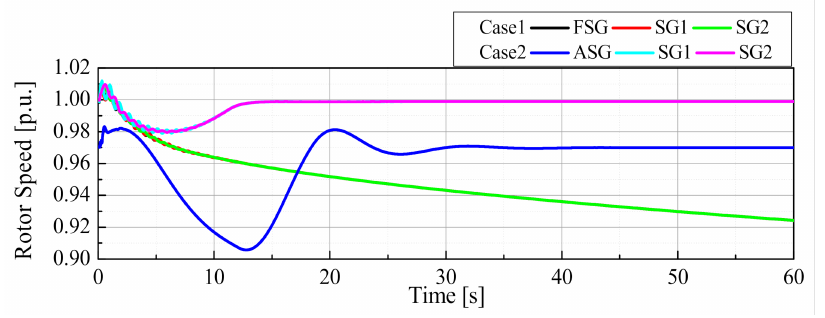
Figure 15. ASG and fixed-rotor-speed pumping generator (FSG) output (Generating Operation).